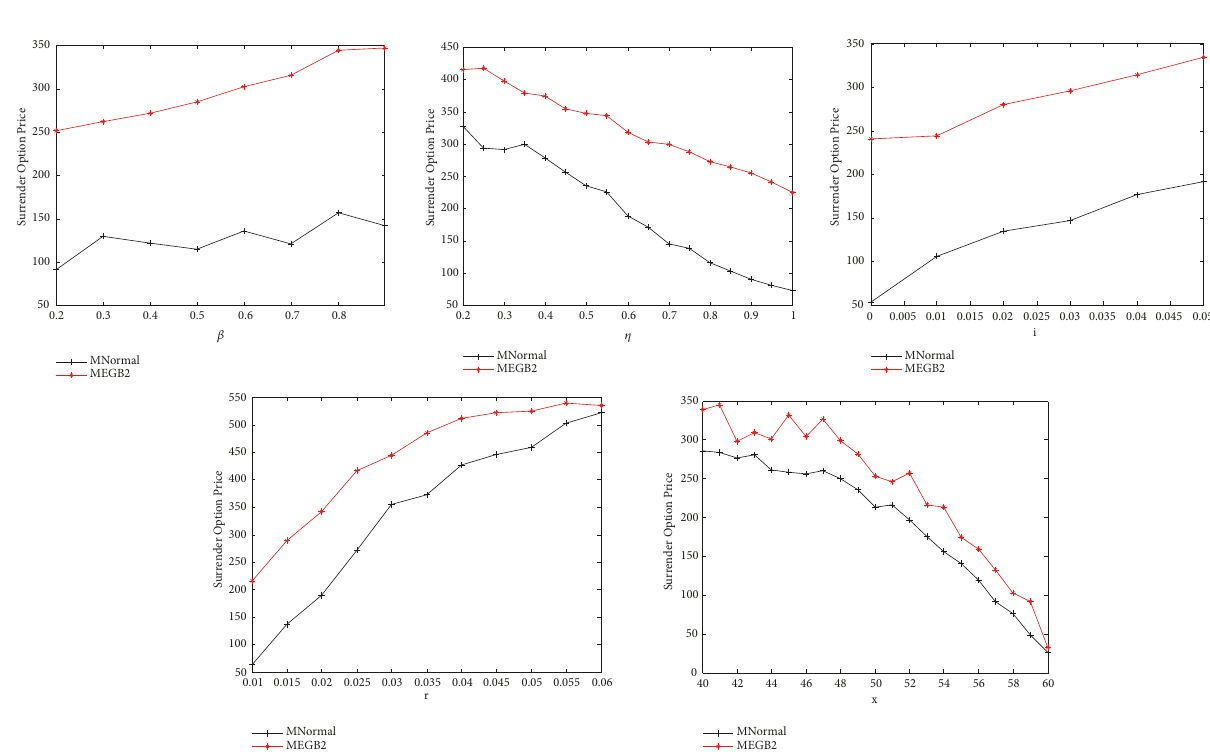
Figure 6: Parameter sensitivity analysis of surrender option between MEGB2 and Multivariate Normal asset